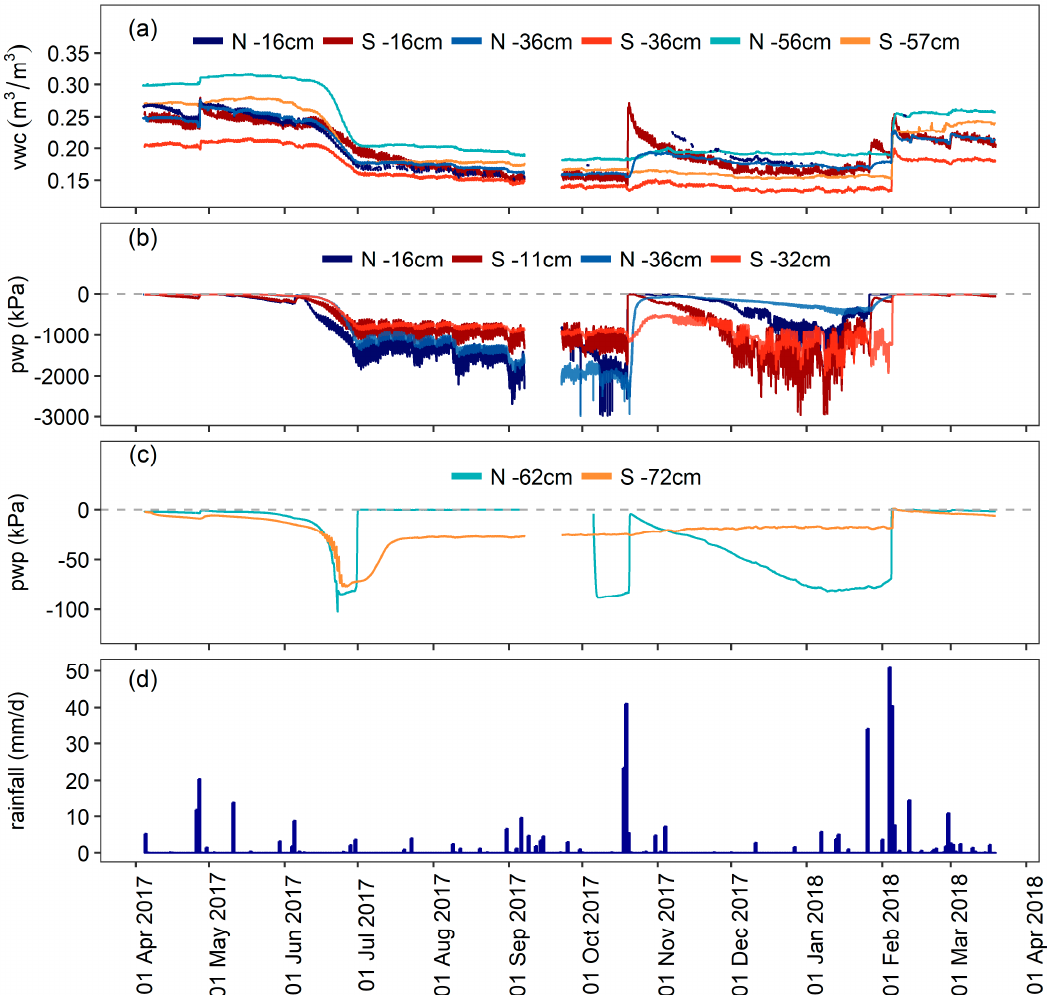
Figure 12. Rainfall infiltration at the North (N) and South (S) slope without vegetation. ( a ) Volumetric water content data measured by 5TE; ( b ) pore water pressure recorded by MPS-6 tensiometers; ( c ) pore water pressure measured by T4 tensiometers; ( d ) daily rainfall.